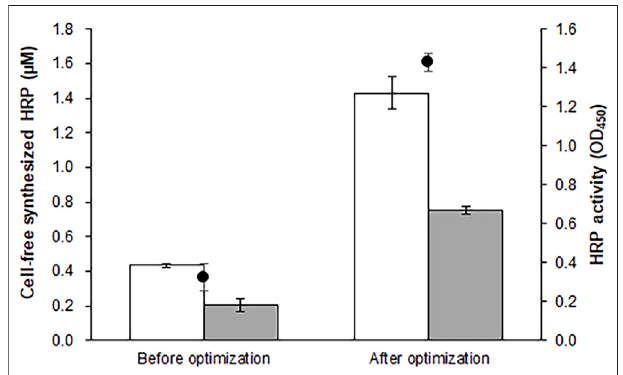
FIGURE 1 | Optimization of reaction conditions for cell-free synthesis of HRP. The reaction mixture was optimized for the synthesis of functional HRP. The graph compares the total and soluble yields (blank and fi led bars, respectively) and enzyme activity (circles) of HRP produced under the reaction conditions before and after the optimization. Measurements were performed in triplicate, and the error bars representthe standard deviations of three independent